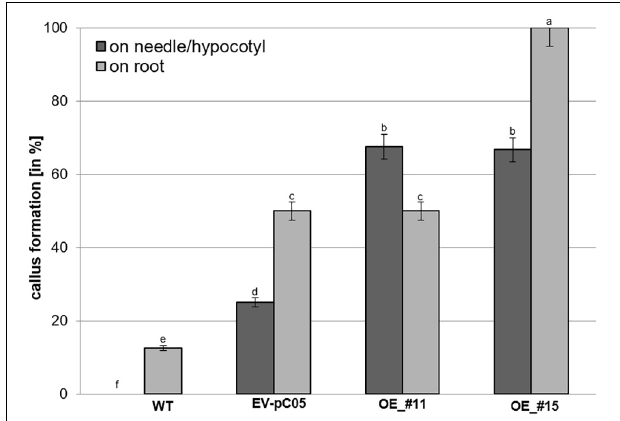
FIGURE 6 | Percentage of non-embryogenic callus formation from P. pinaster primary needle/hypocotyl or root explants ( N ≈ 20) of the 35S::PpWOX2 lines #11 and #15, transgenic EV-pC05, and non-transgenic WT controls in mLV medium without PGR (conversion medium). Each value represents mean ± standard error from three biological replicates and five Petri dishes as technical replicates. Bars with different letters indicate significant differences (ANOVA, P < 0.05).